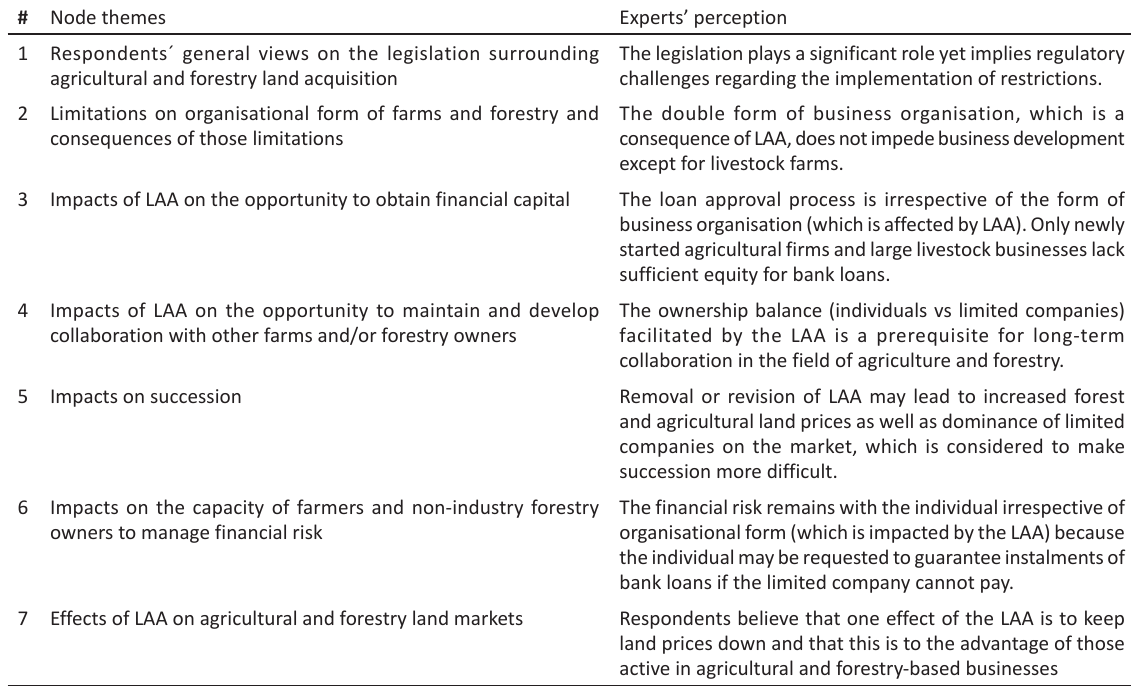
Table 1. Summary of